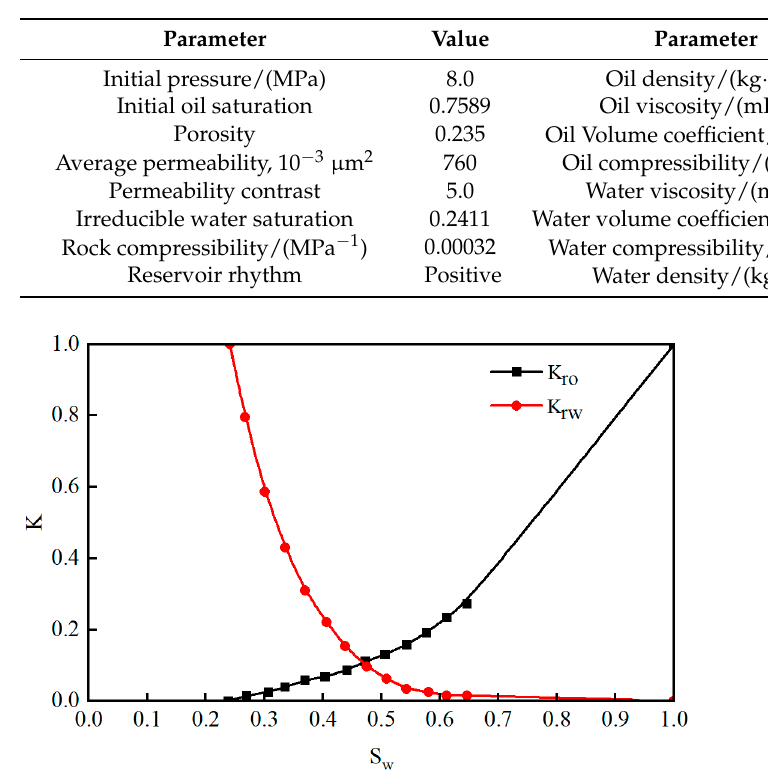
Figure 2. Permeability distribution of the positive − rhythm synthetic model. Table 1. Rock and fluid physical properties used in the positive-rhythm synthetic model.